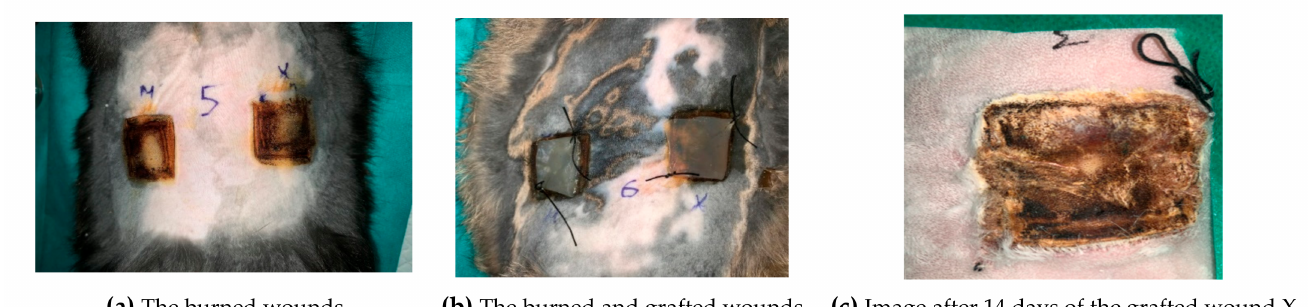
Figure 8. ( a ) illustrates the appearance of the two burned wounds A and X both covered with a dressing; ( b ) one illustrated the case of the burned wounds already grafted as one mentioned above. ( c ) is the appearance of grafted wound after an evolution of 14 days from the grafting date. One notices the appearance of hairs grown in the area of the grafted wound compared to the dorsal area of the rabbit previously cut for clinical study.